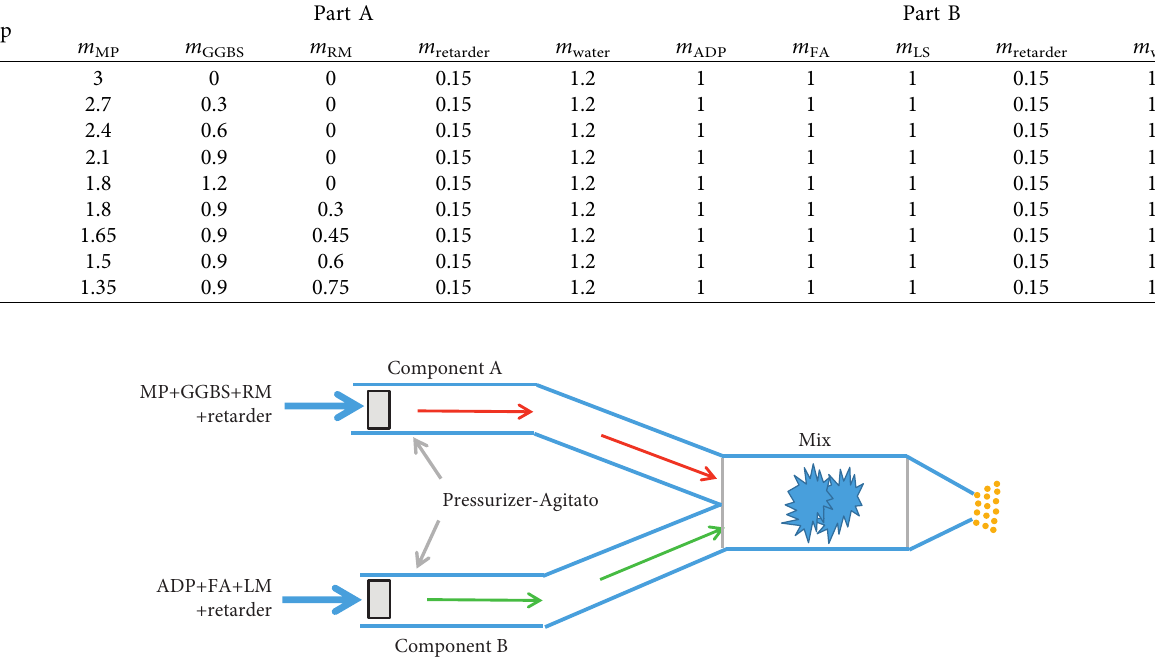
Figure 2: Schematic diagram of two-part grouting method [28].